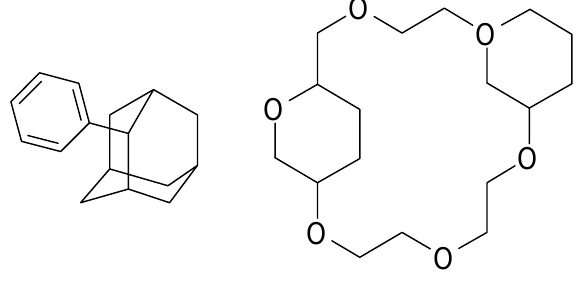
Computer-generated drawings of polycyclic molecules: 2-phenyladamantane and dicyclohexyl-18-crown-6 (some atoms are overlapped). O OO